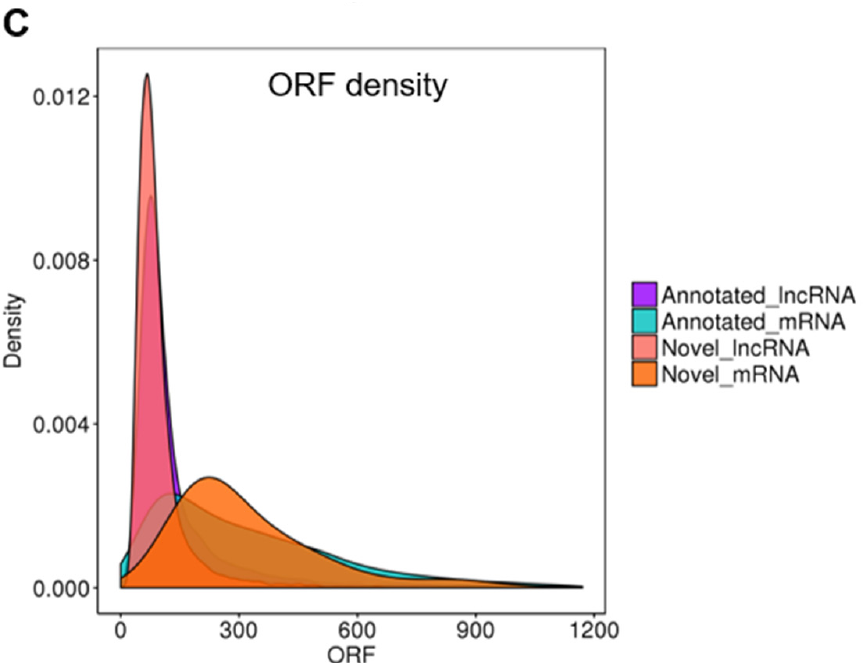
Figure 3. Analysis of lengths, exons, and ORFs of tomato lncRNAs identified in this study when by referencing SL4.0 and annotation ITAG4.0 in tomato. The density representation of number of exons ( A ), length ( B ), and length of ORFs ( C ) of identified lncRNAs. ORF, open reading frame. Anno- tated_lncRNA indicates the lncRNA already identified based on the public datasets. Novel_lncRNA indicates the lncRNA newly identified in this